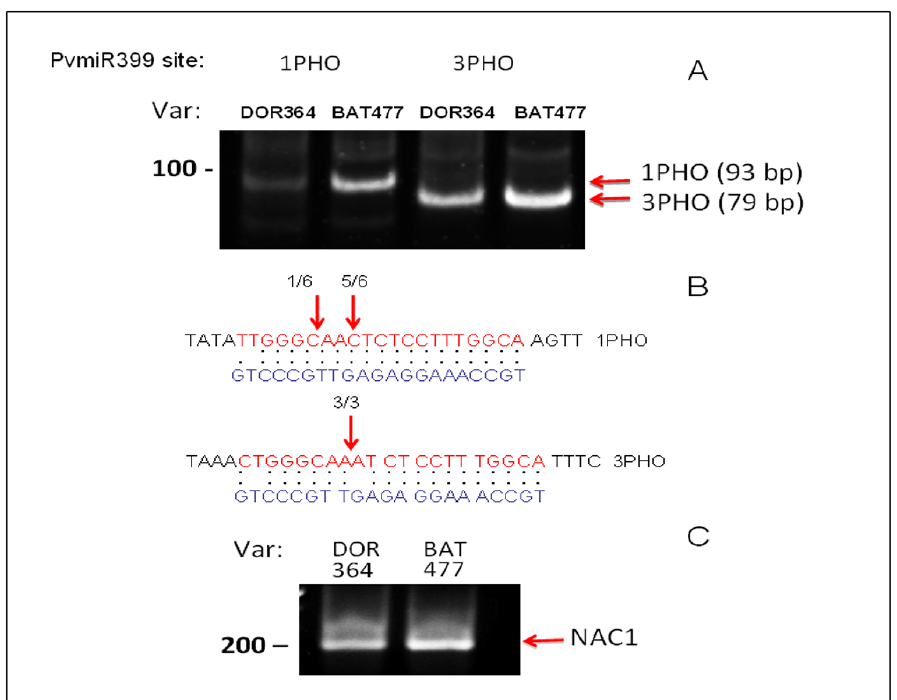
Figure 5. microRNA-directed cleavage of PvPHO2 mRNA. 5'RACE analysis was performed for PvPHO2 using oligonucleotides to specifically determine cleavage directed by PvmiR399 at two recognition sites (1 and 3) in the BAT477 and DOR364 genotypes. ( A ) PCR products corresponding to cleaved PvPHO2 fragments from BAT477 variety were amplified by nested PCR and resolved in a 6% PA gel (arrows indicate size and position of predicted fragments; for procedure details, see the Experimental Section). The corresponding PCR fragments from BAT477 were cloned and sequenced to confirm their identity; ( B ) The alignment between PvPHO2 binding sites 1 and 3 and PvmiR399b is shown; arrows indicate site of cleavage recovered, and numbers refer to number of independent clones analyzed. C . PCR fragments corresponding to cleavage of NAC1 by miR164 that is unrelated to the P -deficiency